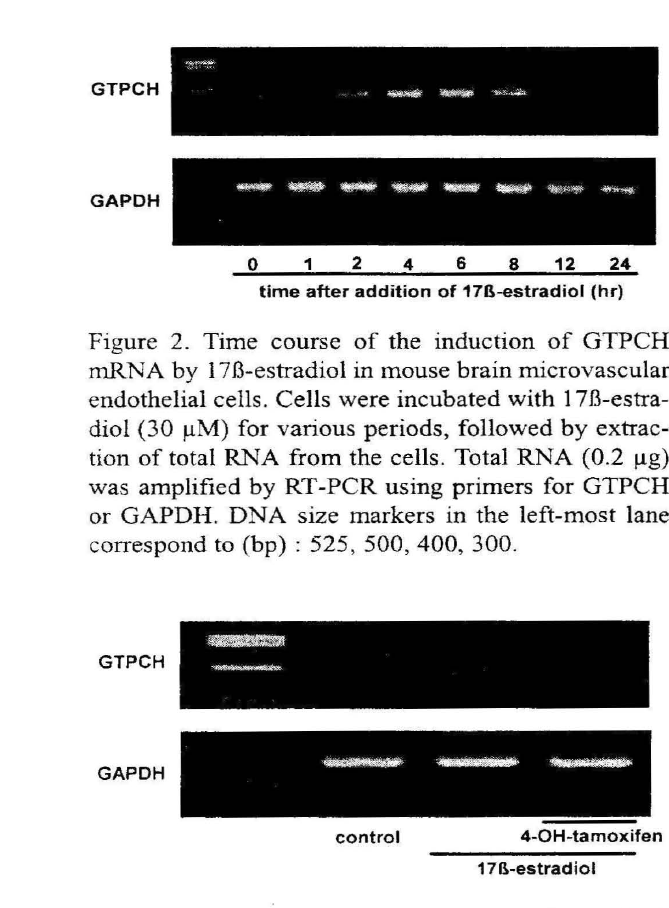
Figure 3. The effect of 4-hydroxy-tamoxifen on 1713- estradiol-induced GTPCH mRNA in mouse brain microvascular endothelial cells. Cells were preincu bated with 4-hydroxy-tamoxifen (0.3 11M) for 1 hr, fol lowed by incubation with 1713-estradiol (30 JlM) in the presence of 4-hydroxy-tamoxifen (0.3 tiM) for 8 hr. Total RNA was prepared from the cells, and the total RNA (0.2 I1g) was amplified by RT-PCR using primers for GTPCH or GAPDH. DNA size markers in the left-most lane correspond to (bp) : 525, 500, 400,